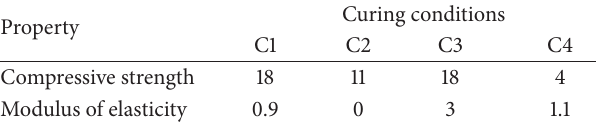
Table 2: Percent increase in compressive strength and modulus of elasticity of SP concrete with respect to control samples under similar curing conditions.